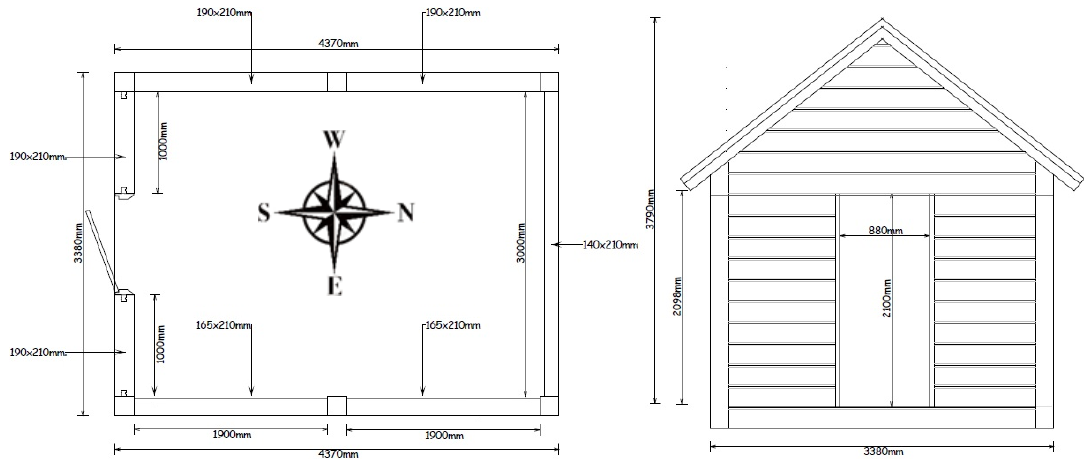
Figure 1. Schematic drawing of the wooden cabin. The test objects are the west-, north- and east-facing external walls.